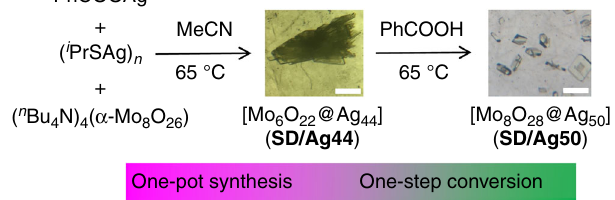
Fig. 1 Synthesis and transformation routes for SD/Ag44 and SD/Ag50 .